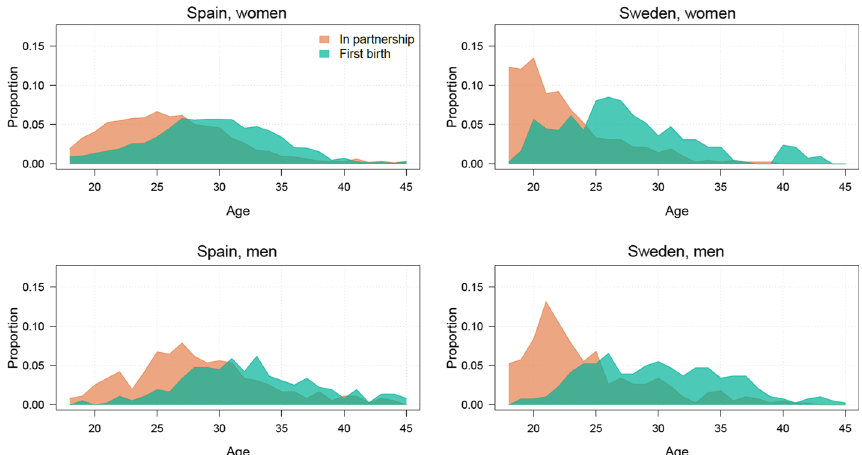
Fig. 2 Timing and intensity of first event occurrences by age, 1965–1969. Source: Calculated by authors based on the Spanish Fertility Survey (2018) and Swedish Generations and Gender Survey (2013) from the Harmonized Histories